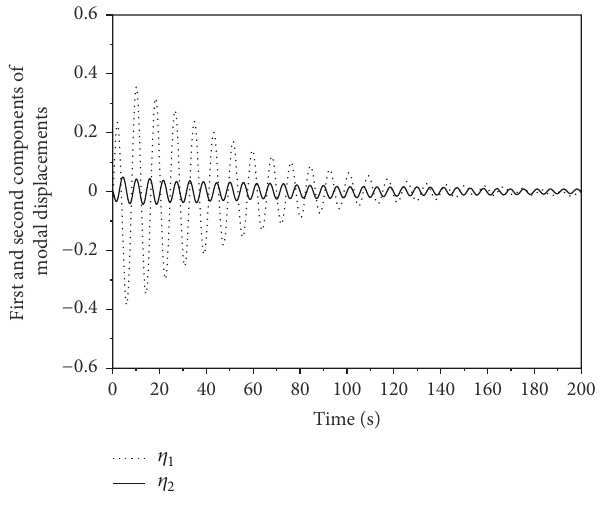
Figure 6: First and second modes under PD-SMC.